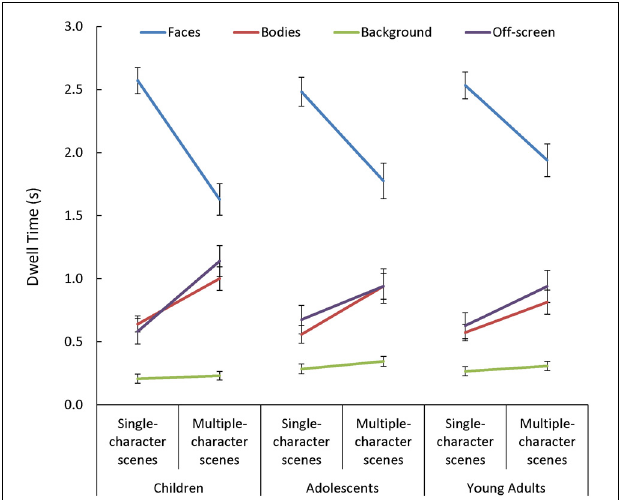
FIGURE 6 | The mean dwell time (s) in each area of interest (AOI: faces, bodies, backgrounds) and off-screen while participants viewed static and dynamic, single- and multiple-character scenes. The Scene Type × AOI interaction seen with static scenes was amplified with the addition of dynamic cues. This was primarily due to the fact that viewers were more drawn to examine moving faces in single-than in multiple-character scenes.